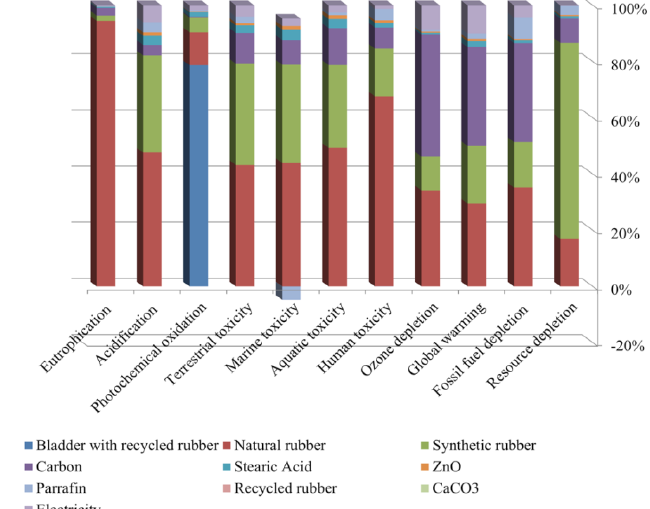
Figure 3. Environmental flow of 1 Kg of ball bladder produced with recycled rubber